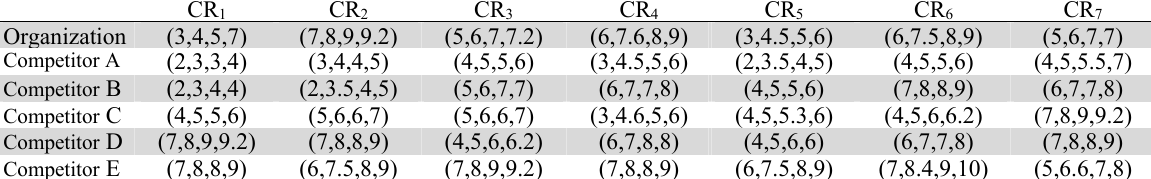
Fig. 3. The tree diagram of customers’ requirements (Saaty & Tran, 2007) The final matrix of performance evaluation of the organization product and